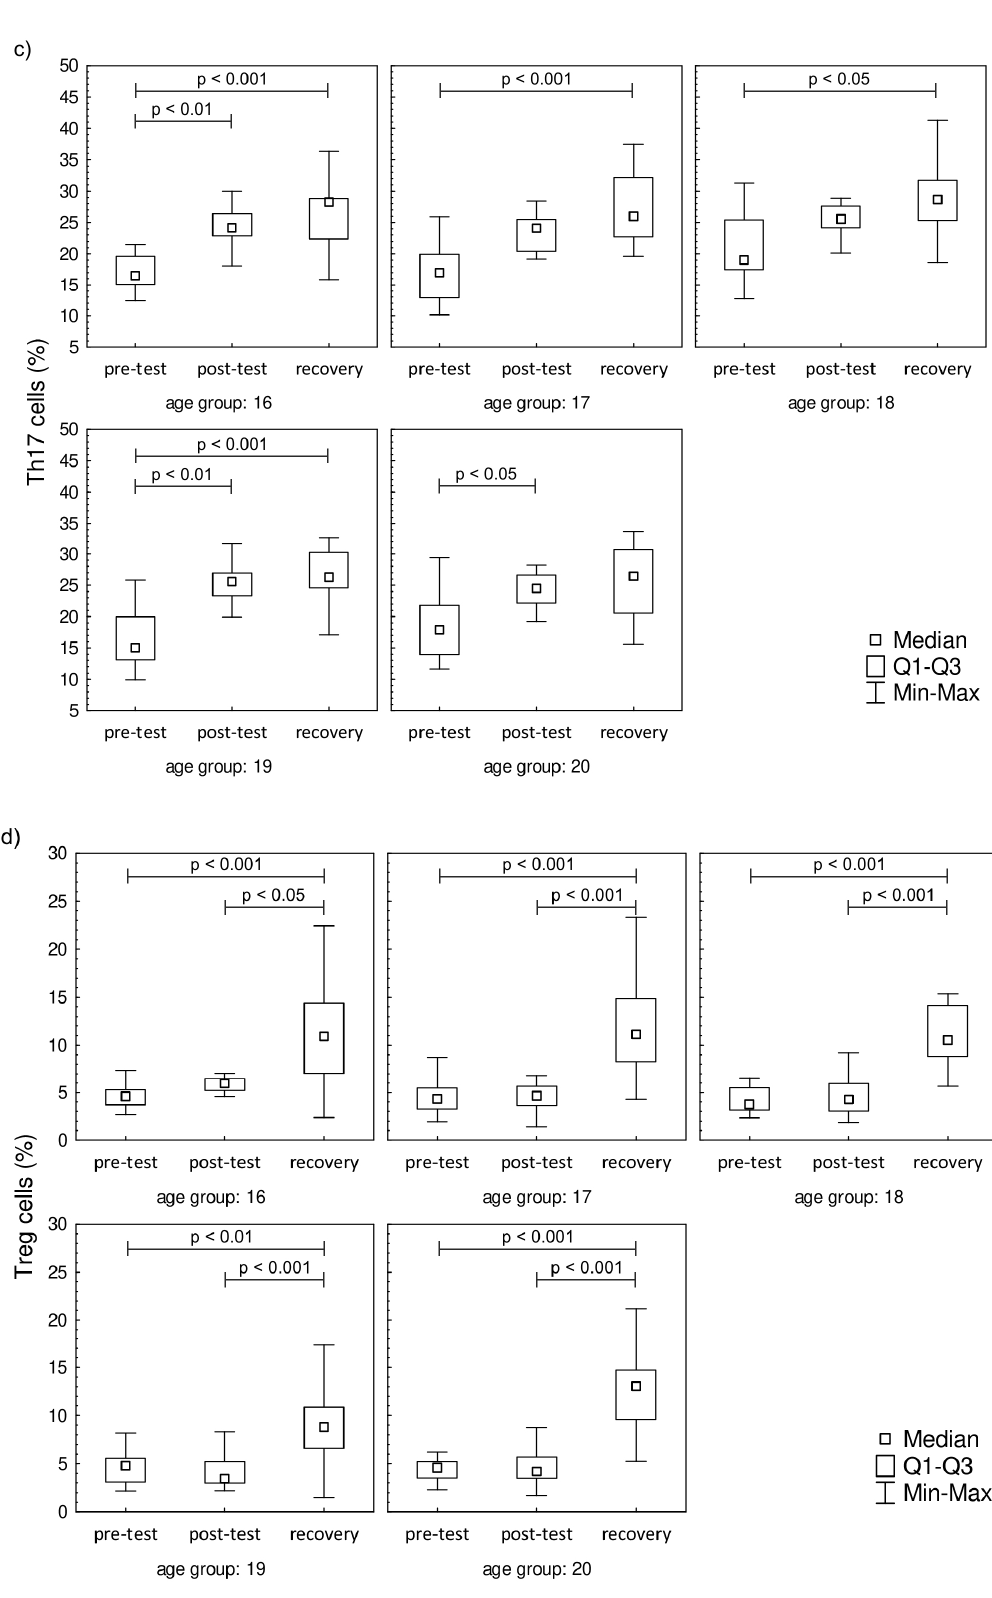
Figure 2. Th cell subsets in isolated lymphocytes from peripheral blood of the participants. ( a ) Th1 cell percentage; ( b ) Th2 cell percentage; ( c ) Th17 cell percentage; ( d ) Treg cell percentage. Significance levels of di ff erences observed between analyzed time points (pre-test vs. post-test vs. recovery) were assessed using Friedman’s analysis of variance for repeated measures followed by post hoc Dunn’s test with Bonferroni